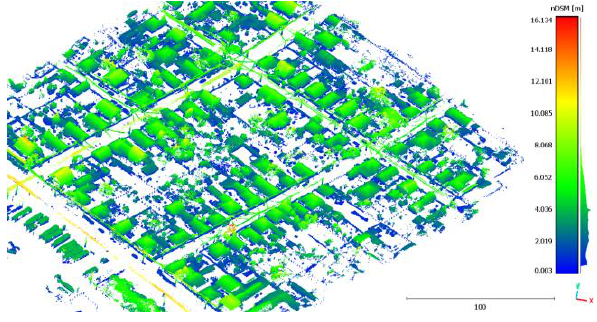
Figure 3 . Normalised Surface Model, ground and low vegetation points removed.